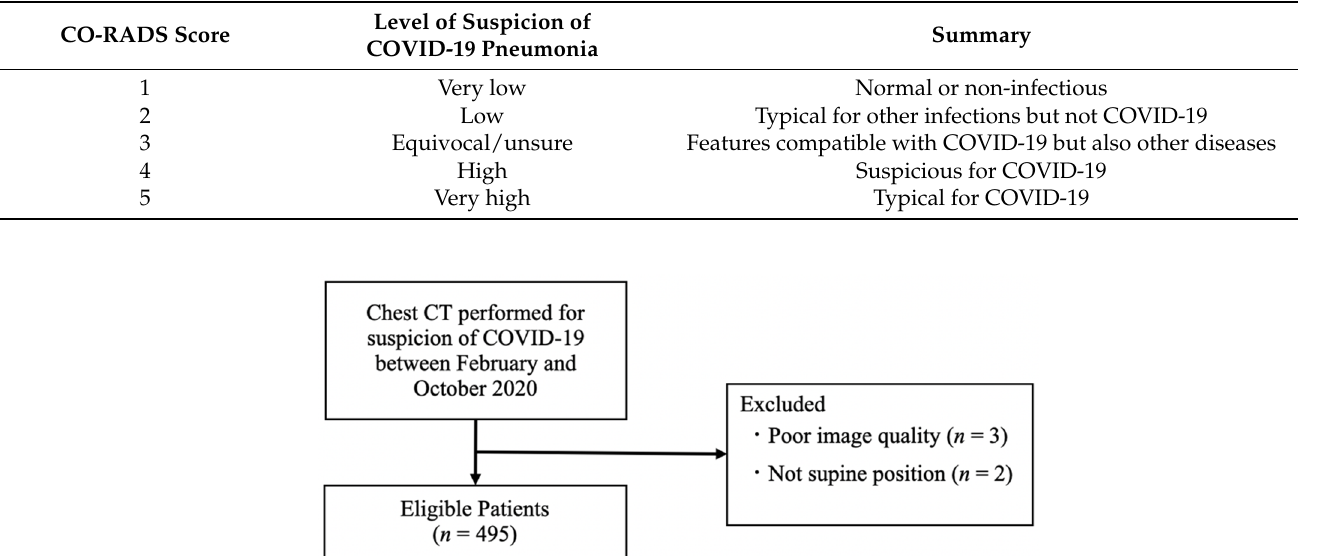
Table 1. CO-RADS Scores and Summary Adapted with permission from ref. [7]. Copyright © 2020, RSNA.